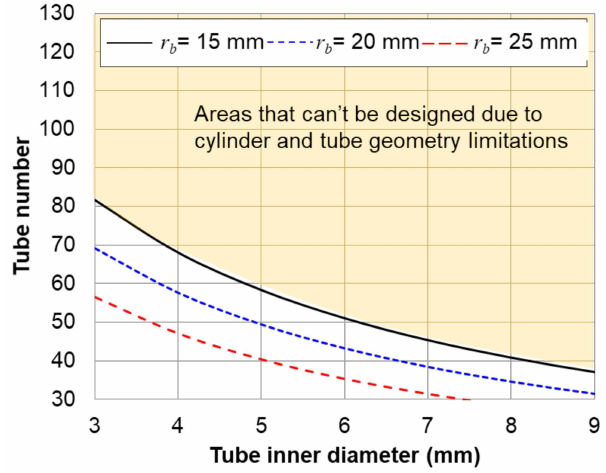
Figure 3. Maximum number of tubes applicable according to applicable tube inner diameter and tube bending